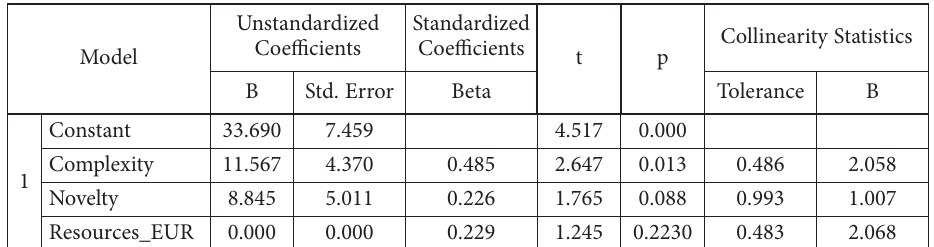
Table 10. Regression coefficient